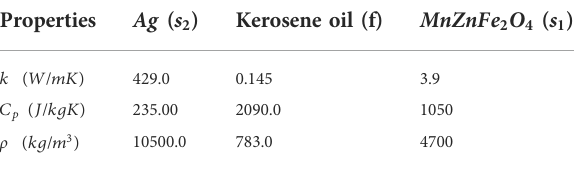
TABLE 1 Thermal properties of silver, kerosene oil, and manganese zinc ferrite.